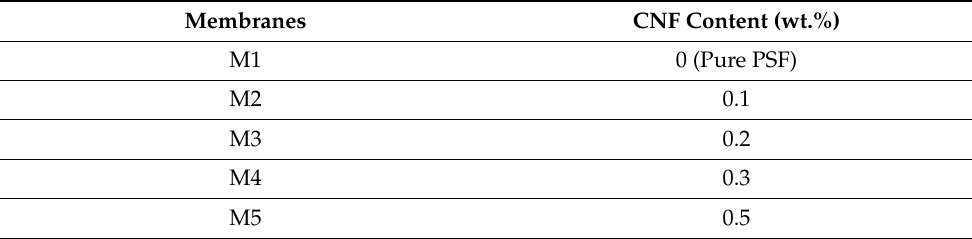
Table 1. Composition of fabricated PSF membranes.